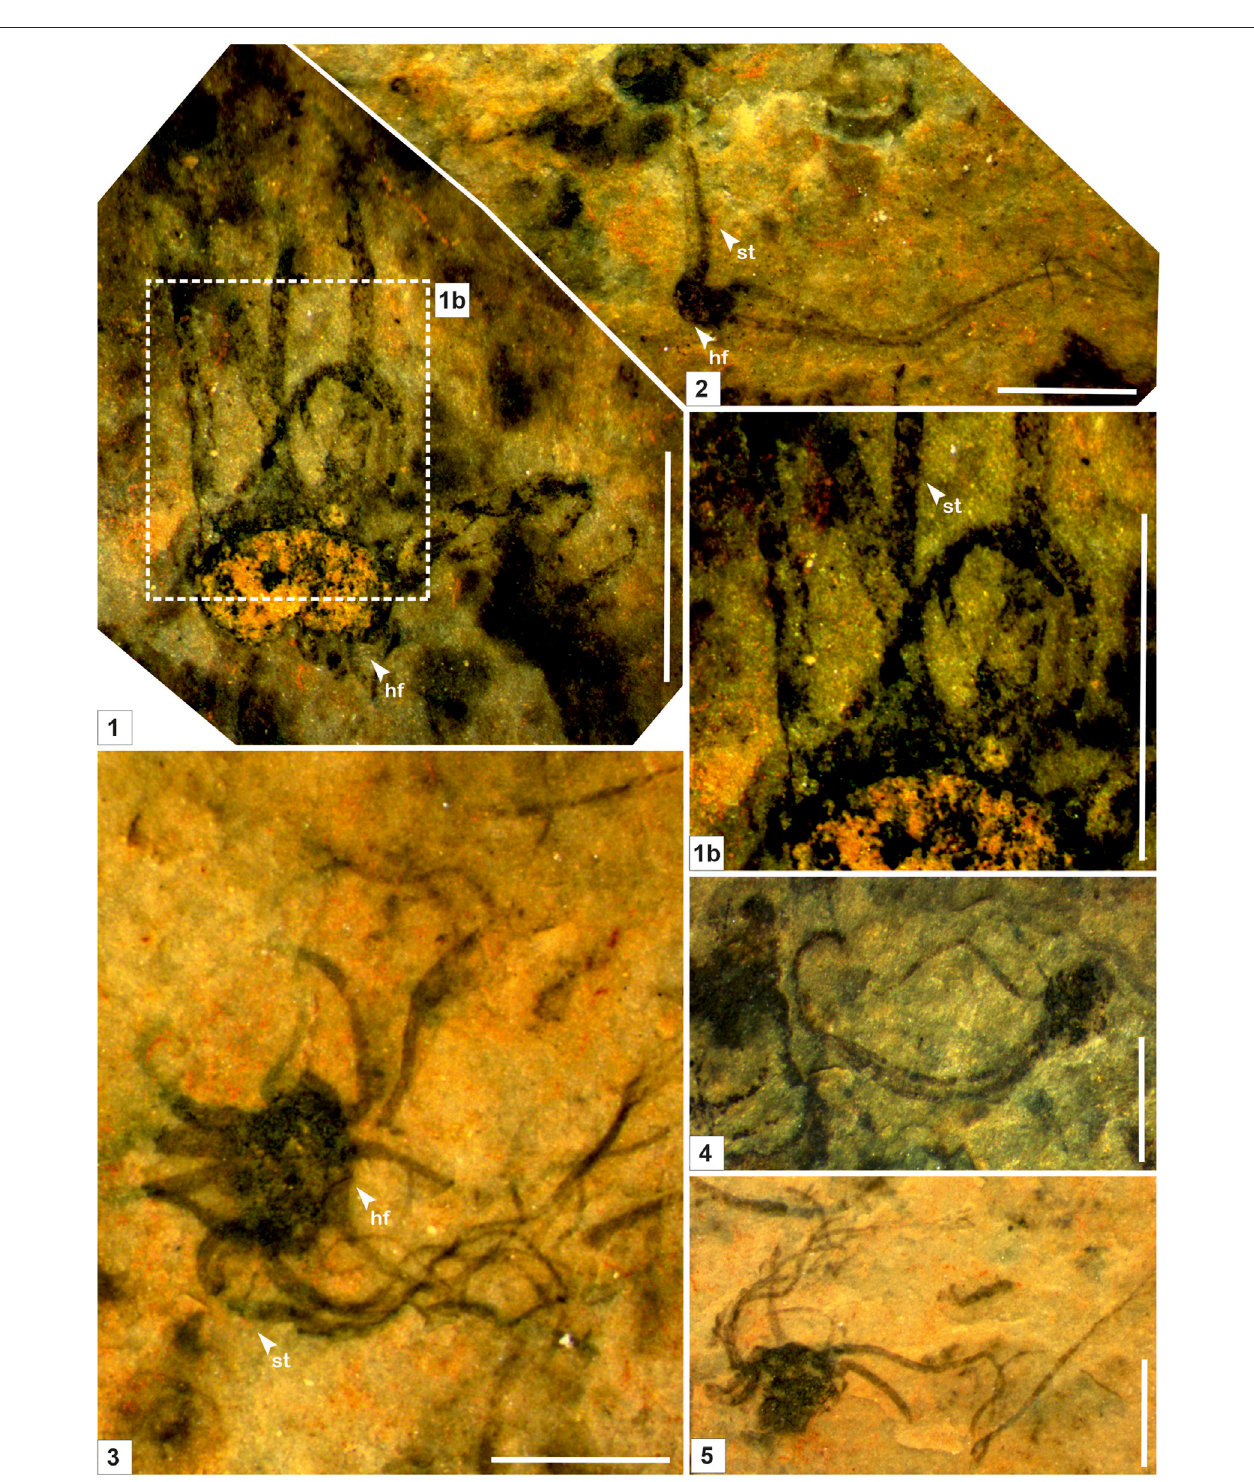
FIGURE 3 | Macroscopic fossil Palaeoscytosiphon shuklaii n. gen., n. sp. from the Saraipali Formation (arrow indicates the prominent features: st. stalk; br. branching; hf. holdfast) (1 – 5) . 1b . Enlarged view of connection between stalk and holdfast. 1, 2 . Specimen no. BSIP 42022; 3 . Specimen no. BSIP 42023; 4 . Specimen no. BSIP 42021; 5 . Specimen no. BSIP 42024. Scale bar is 2.0 mm for each specimen.